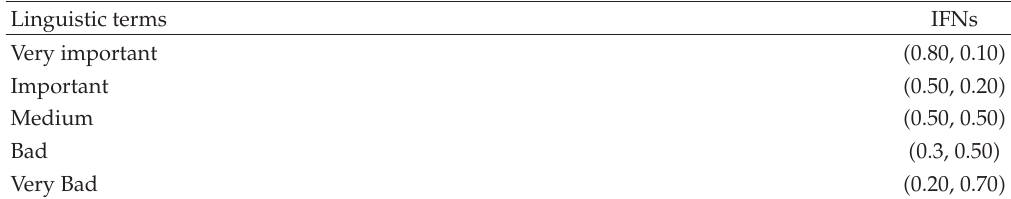
Table 1: Linguistic term for rating DMs.